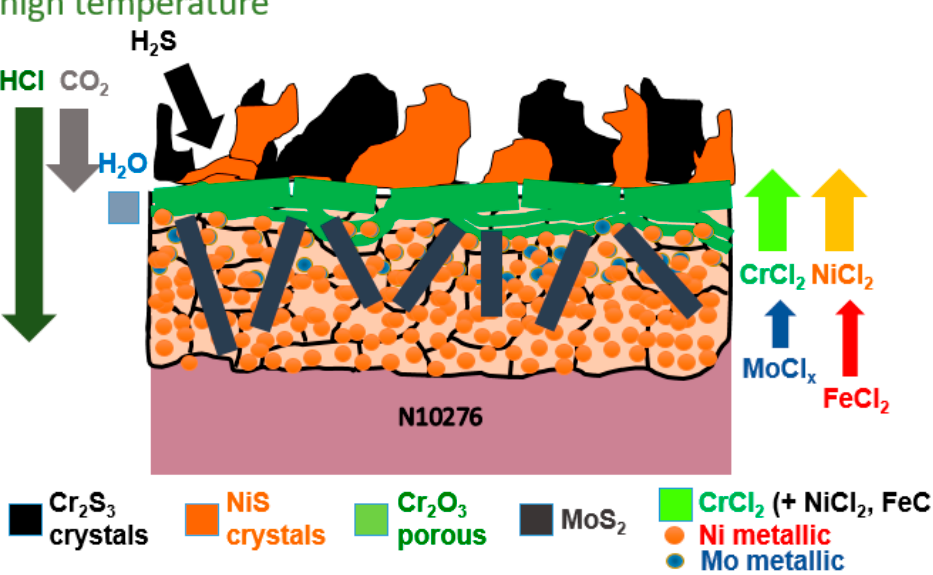
Figure 9. Schematic illustration of the proposed corrosion mechanism for N10276 at 680